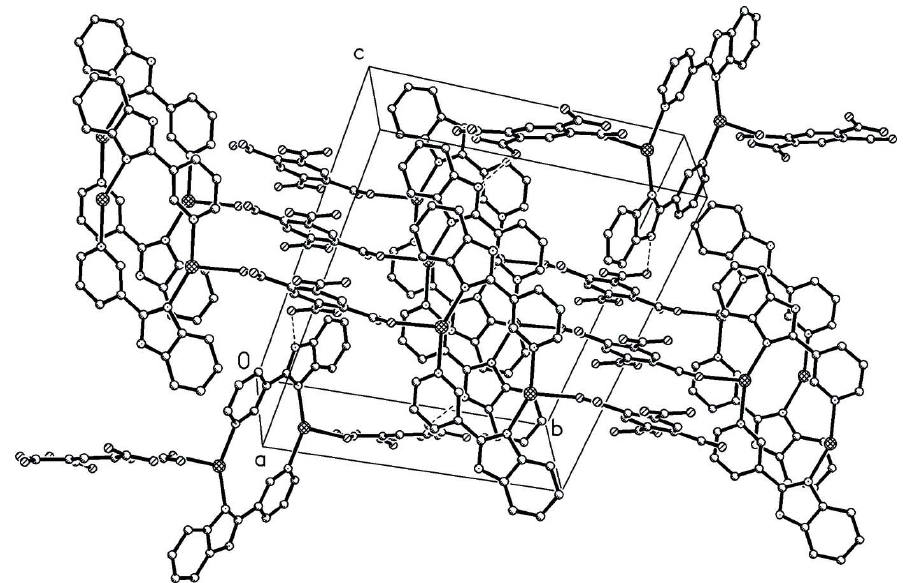
Figure 3 The crystal packing of (I). H atoms are omitted for